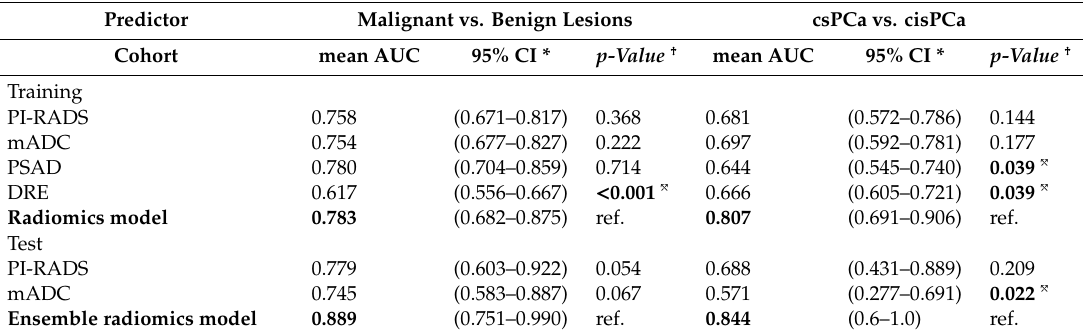
Table 2. Results of ROC analysis for the two selected classification tasks. Predictor malignant vs. benign lesions csPCa vs. cisPCa calculated with DeLong test for di ff erences in AUC ROC compared with the reference ( = ref.).